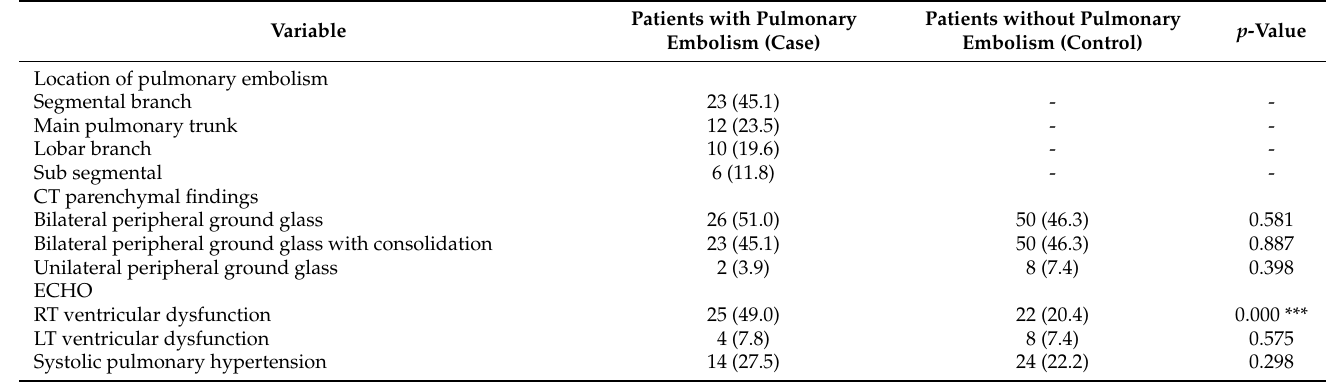
Table 3. Radiological and ECHO